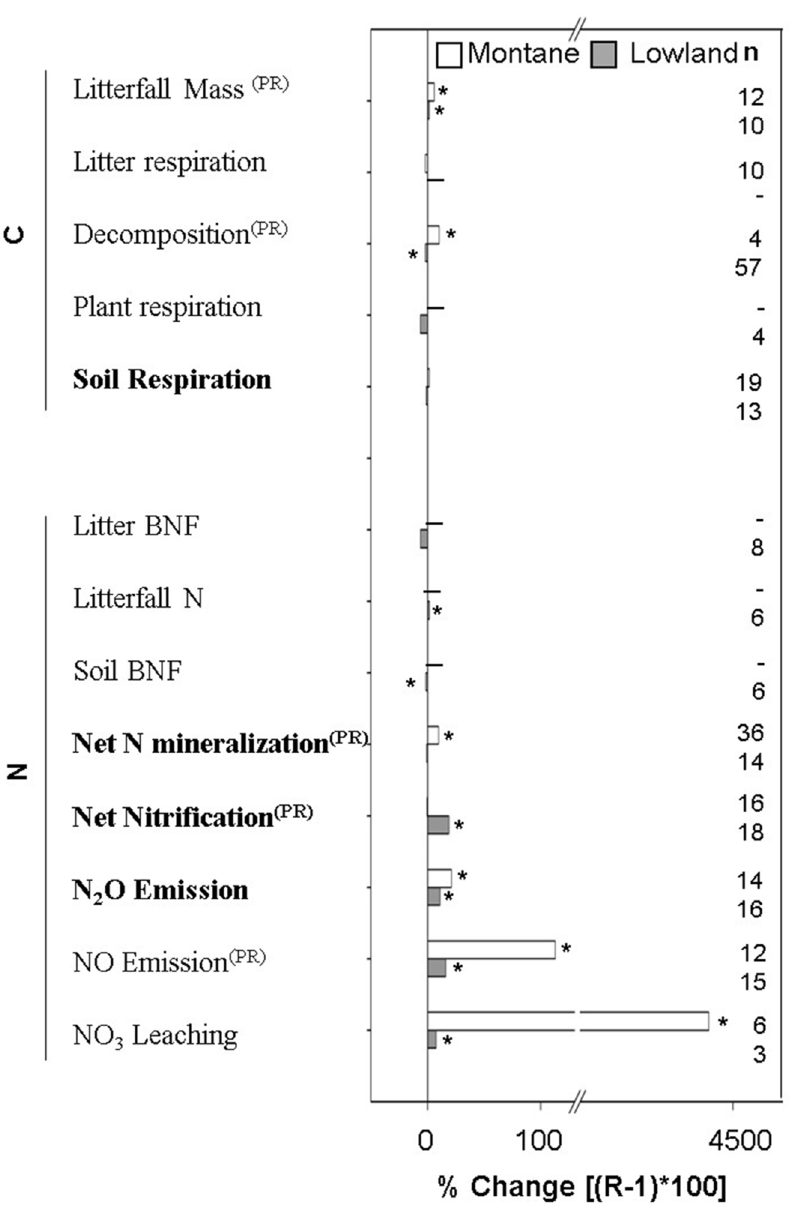
Fig 4. Percentage of change for flux variables. An asterisk ( * ) represents a significant percentage of change with the N addition. A PR superscript indicates significantly different change between montane and lowland forests (ProRand (cid:3) 0.05). Bolded variables represent significant associated total heterogeneity (Qt; p (cid:3)